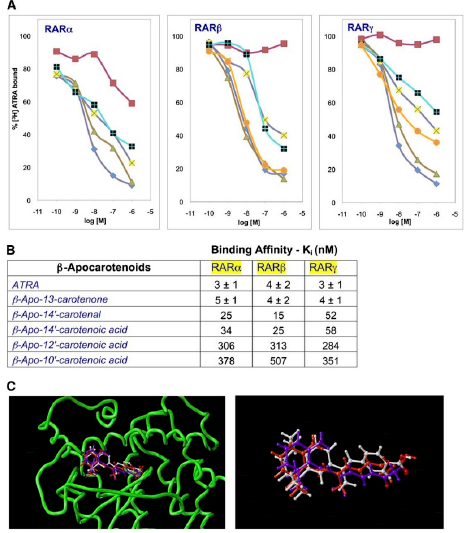
Figure 3. β -Apo-13-carotenone is a high-affinity ligand for purified retinoic acid receptors and fits into the ligand-binding site: ( A ) competitive displacement of 5 nM tritiated atRA from purified RAR proteins by unlabeled atRA (filled diamond) as a positive control, β -apo-13-carotenone (filled triangle), 14 ′ -CA (plus), 14 ′ -AL (cross), and 13-cis-RA (filled square) as a negative control for the RAR α (left) experiment, and CD 2665 (filled circle) and retinyl acetate (filled square) as a negative control for RAR β (middle) and RAR γ (right) experiments; ( B ) binding affinities (in nM) of β -apocarotenoids to RARs calculated from the data shown in ( A ) and additional experiments with β -apo-12 (cid:48) -and β -apo- 10 (cid:48) -carotenoic acids. For atRA and β -apo-13-carotenone, variance shown is for three independent experiments; ( C ) molecular modeling of the docking of atRA (red) and β -apo-13-carotenone (purple) into the ligand-binding site (protein backbone in green) of RAR β (PDB entry:1xap) (left). Shown on the right is the energy minimized then docked conformations of atRA (red) and β -apo-13-carotenone (purple) overlaid onto the conformation of the agonist TTNPB (white) as observed in the X-ray structure. Taken from reference [34] and used with